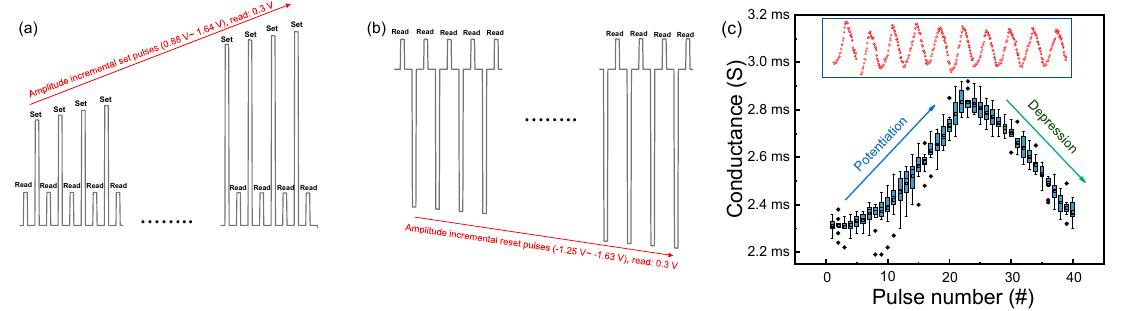
Figure 7. LTP and LTD characteristics of the Cu / AlN / TiN device. ( a ) Incremental pulse schemes for potentiation and ( b ) depression; ( c ) LTP and LTD characteristics in 10 cycles.